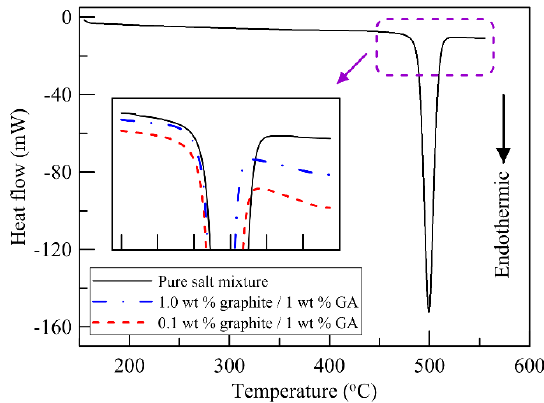
Figure 3. Heat-flow curves of the pure salt eutectic and the nanofluids, obtained via DSC measurements.